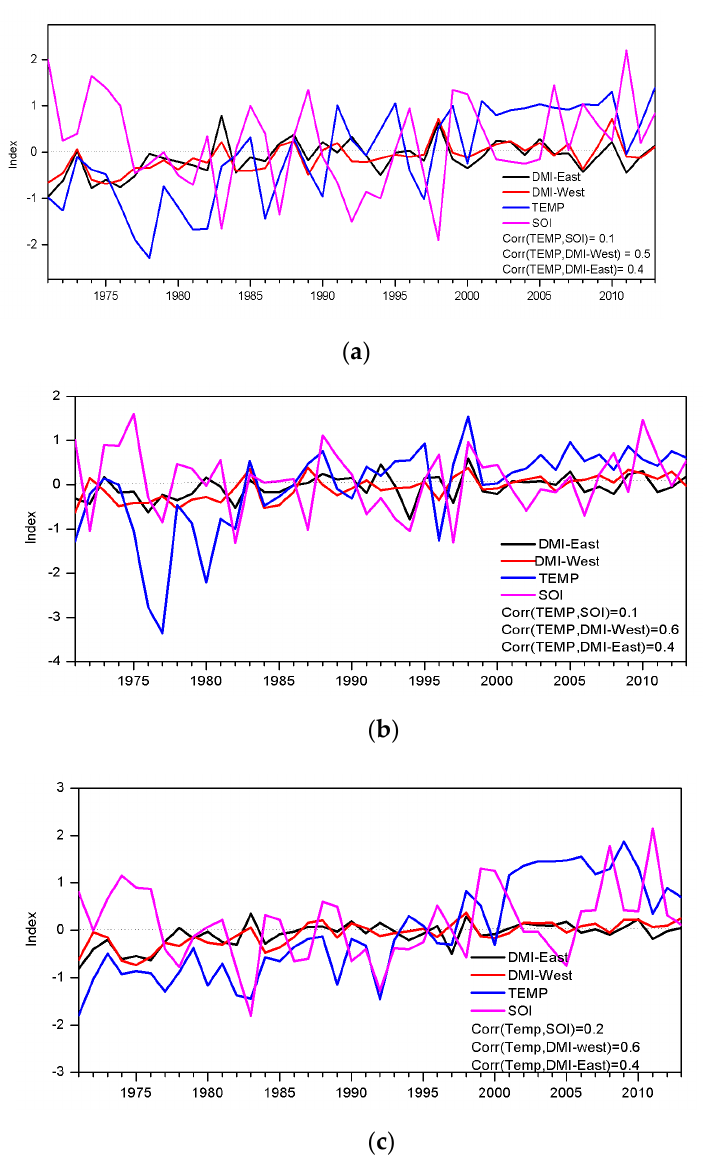
Figure 12. Interannual variability for ( a ) summer between Southern Oscillation Index (SOI), Dipole Mode Index (DMI)-West, and DMI-East and average standardized temperature anomaly; ( b ) rainy season between SOI, DMI-West, DMI-East and average standardized temperature anomaly; and ( c ) winter between SOI, DMI-West, DMI-East and average standardized temperature anomaly (1971–2013) over Myanmar.